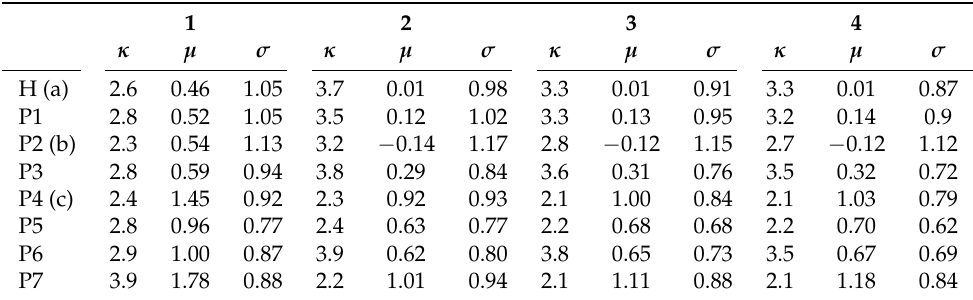
Table 2. Kurtosis ( κ ), mean ( µ ) and standard deviation ( σ ) for the distribution of ratio R L for a healthy participant (H) and stroke patients (P). Four κ − µ − σ column sets represent different segmentation methods: path-based movement segmentation (column 1 ), and time-based segmentation into one (column 2 ), three (column 3 ) and five (column 4 ) second movement